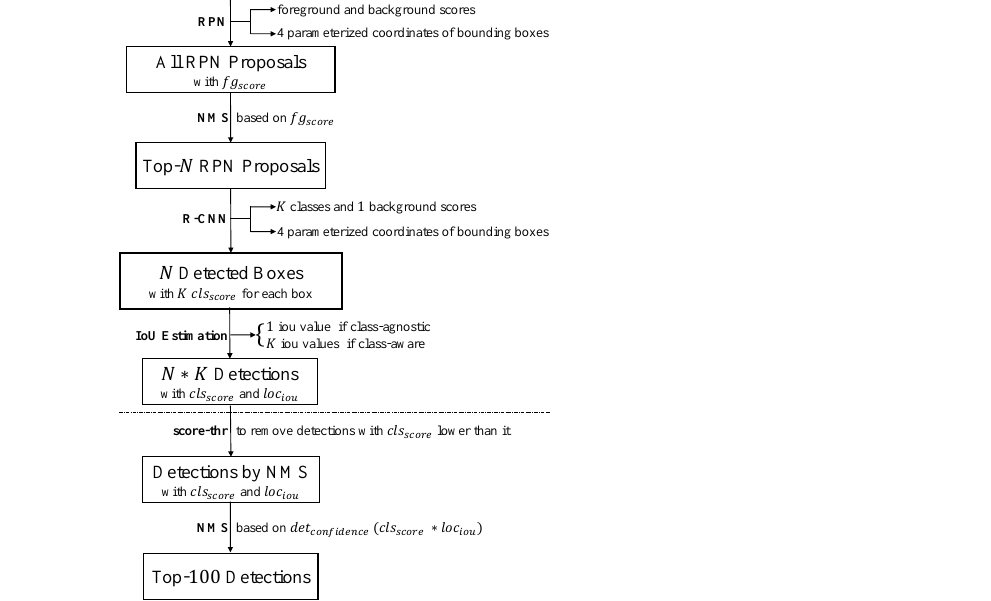
Figure 4. The overall pipeline of our two-stage detector of IoU-Aware R-CNN. We change the way to choose the top-N detections. This simple but powerful branch demonstrates significant improvement in detection